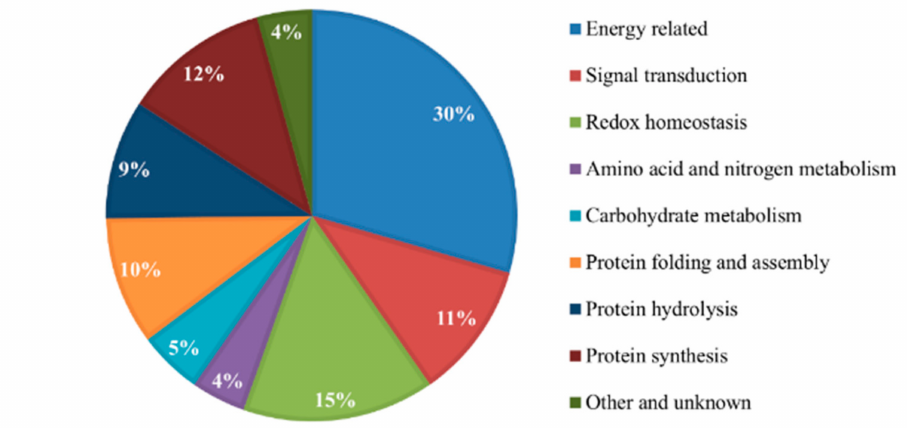
Figure 2. Shows the classification of the 139 proteins expressed differentially in two rice cultivars, blast-resistant Minghui and blast-susceptible Nipponbare.